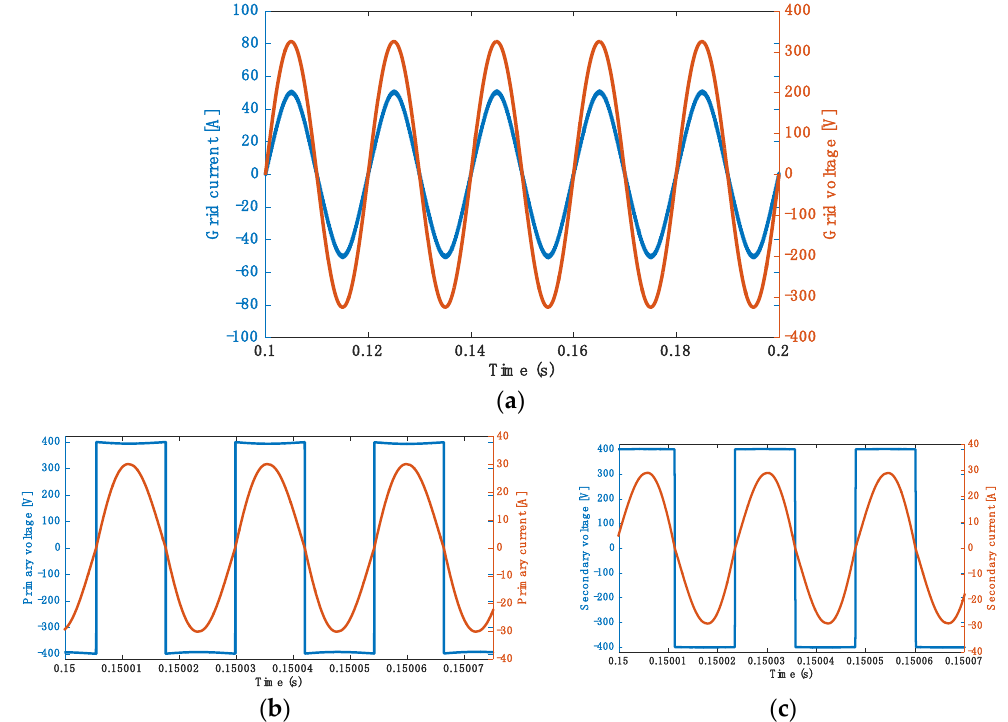
Figure 13. G2V: ( a ) Grid voltage and current; ( b ) Primary resonant voltage and current; ( c ) Secondary resonant voltage and current.